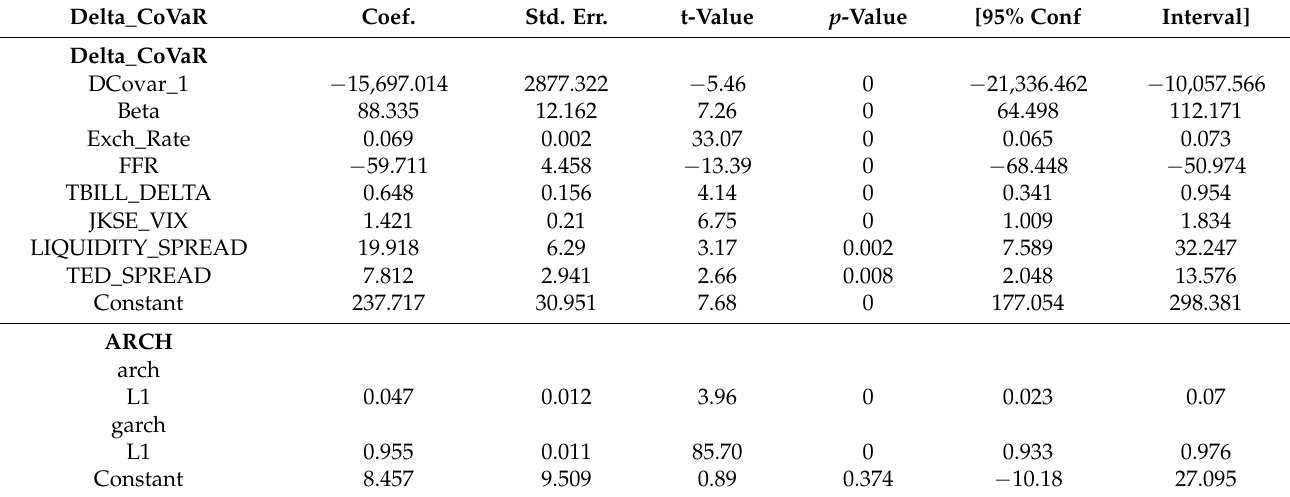
Table 12. CoVaR ARCH(1,1)